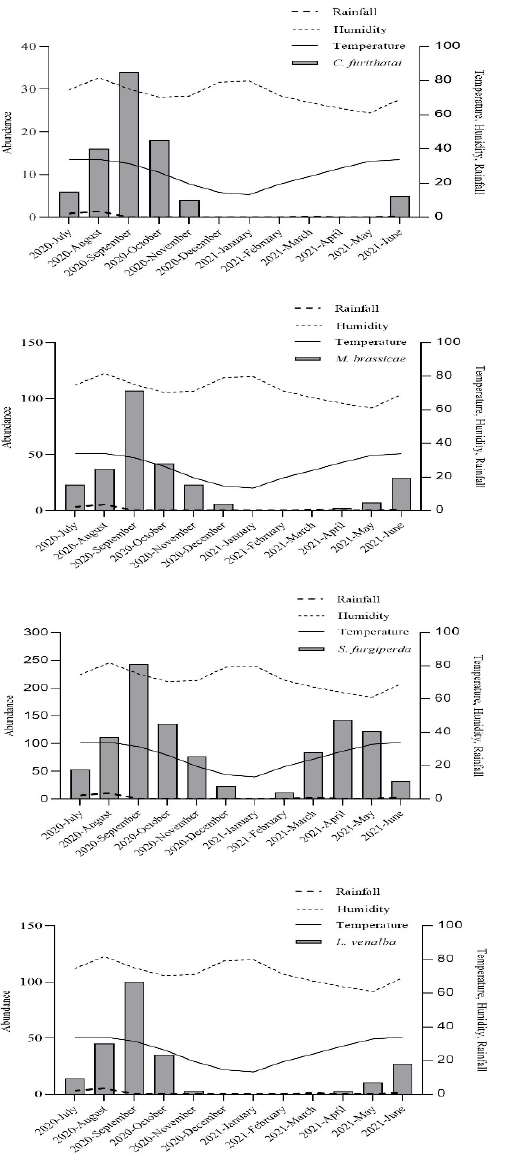
Figure 2. Temporal distribution patterns of S. litura, H. tripoli, H. Jahangiri, H. armigera, S. exigua,